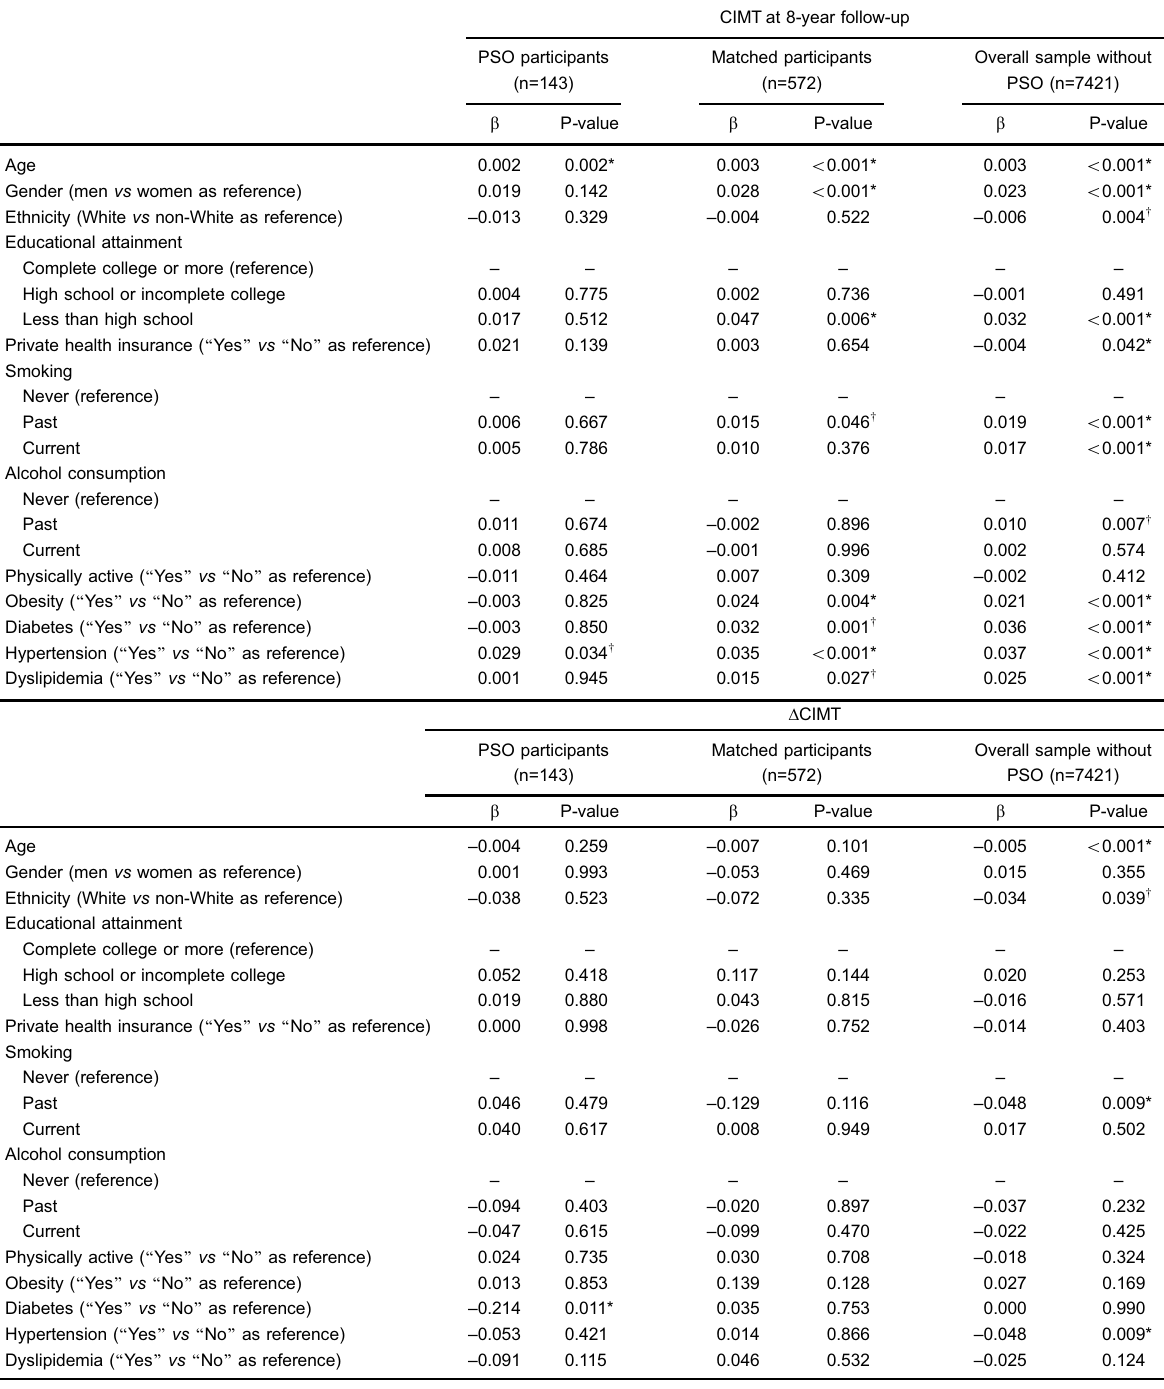
Table 2. Longitudinal associations between carotid intima-media thickness (CIMT) and sociodemographic and traditional cardiovascular risk factors in adults with and without psoriasis (PSO)